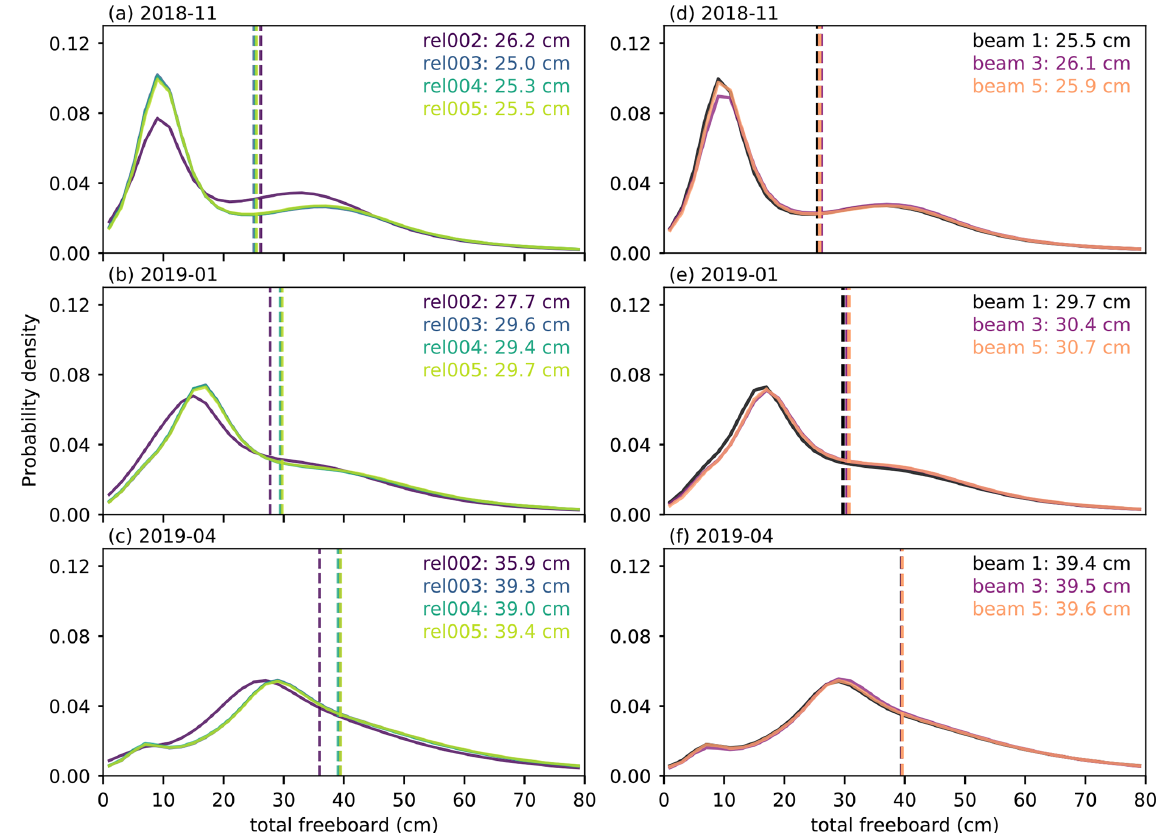
Figure 6. Probability distributions in November 2018 (a,d) , January 2019 (b,e) and April 2019 (c,f) of ATL10 total freeboard for (a– c) Release 002 (rel002) to Release 005 (rel005) using beam 1 (strong) and (d–f) strong beam 1, 3 and 5 (all three strong beams) for Release 005 (rel005) data. All distributions only show data collected within an Inner Arctic Ocean domain (Fig. 5). Dashed lines show the mean values of each